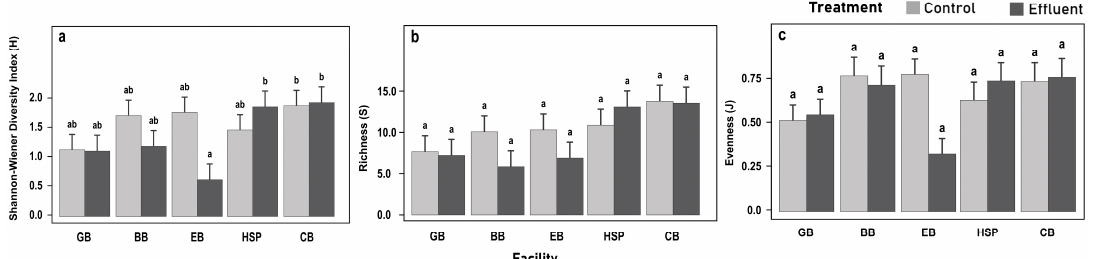
Figure 9. Plot mean and standard error ( n = 5) for understory ( a ) Shannon–Wiener diversity index; ( b ) richness; and ( c ) evenness. Same letters over bars indicate no differences between treatment levels at α = 0.10. Facility abbreviations are as described in Figure 2. Facilities are arranged in establishment order with GB being first (1978) and CB last (2013).